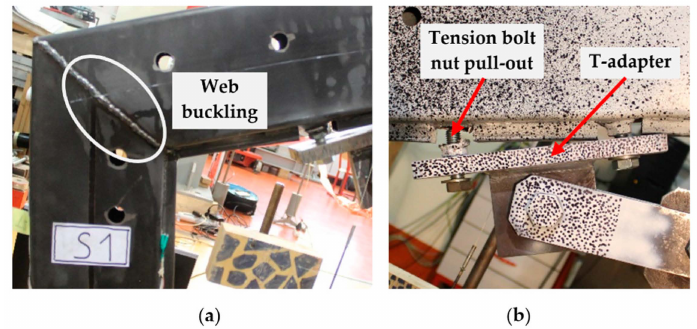
Figure 10. Failure mode of the steel knee joint: ( a ) local web buckling in the knee joint connection region; ( b ) tensile bolt nut weld